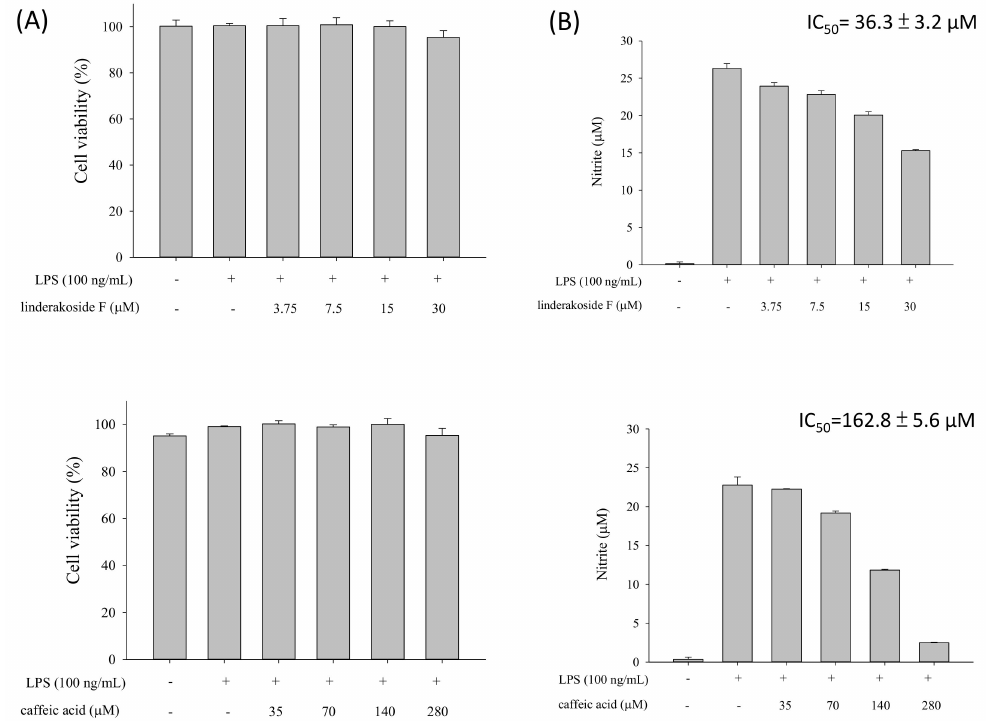
Figure 3. ( A ) Cytotoxicity of linderakoside F and caffeic acid in LPS-stimulated RAW264.7 cells. Cells were treated with linderakoside F at 3.75, 7.5, 15, 30 µ M and caffeic acid at 35, 70, 140, 280 µ M for 24 h, and cell viability was assayed by the MTT assay. Data were expressed as the means ± S.D. of three respectively experiments. ( B ) Effect of linderakoside F ( 1 ) and caffeic acid on NO production in LPS-stimulated RAW264.7 cells. Cells were incubated with LPS (100 ng/mL) in the presence of following doses at 3.75, 7.5, 15, 30 µ M and 35, 70, 140, 280 µ M of linderakoside F ( 1 ) and caffeic acid respectively for 24 h. Values were expressed as mean ± S.D. of three replicates. Mean with different letters represent significantly different ( p < 0.05) by Scheff é ’s